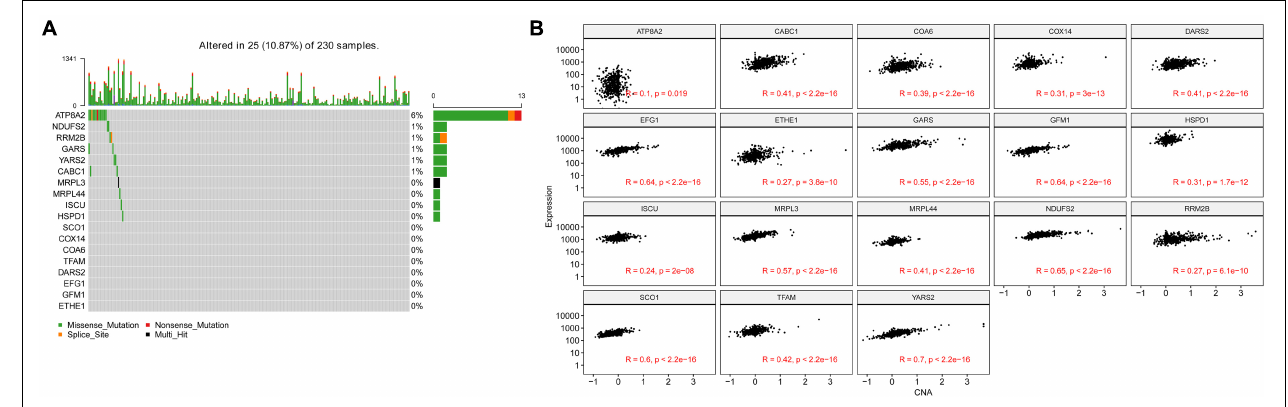
FIGURE 7 | Genetic alteration and copy number alterations (CNAs) of the 18 genes in LUAD samples. (A) Genetic alteration percentage of 18 genes. (B) Correlation of each 18 genes mRNA expression level and linearized copy-number alteration.